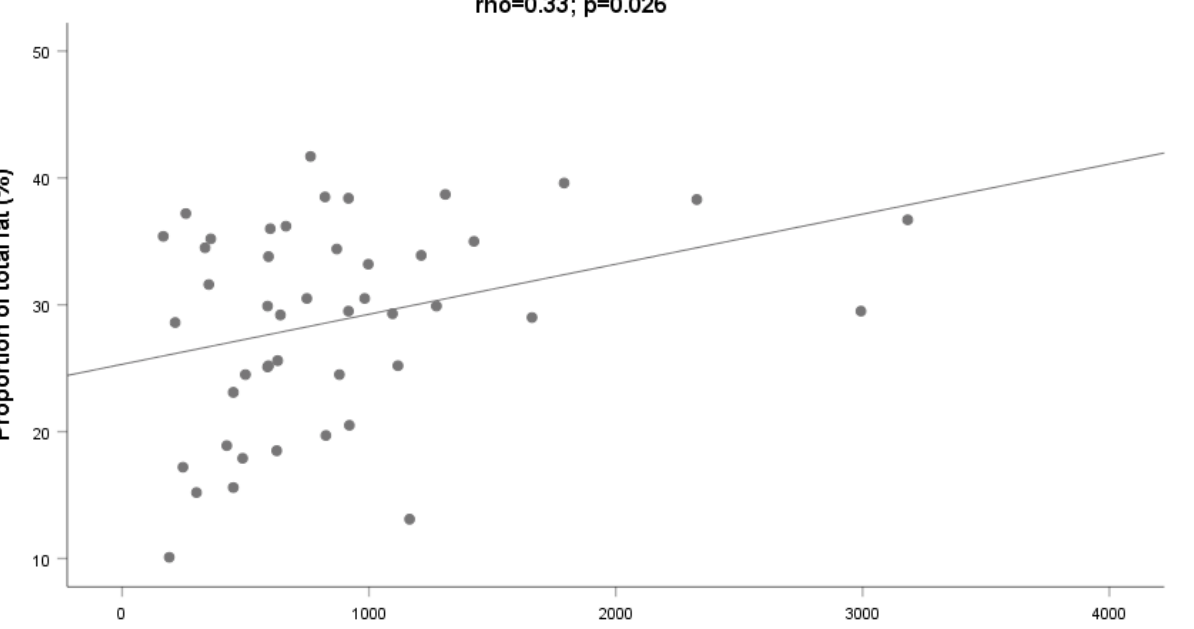
Figure 2. Relationship between serum myostatin and proportion of total fat among heavy drinkers (N = 46).